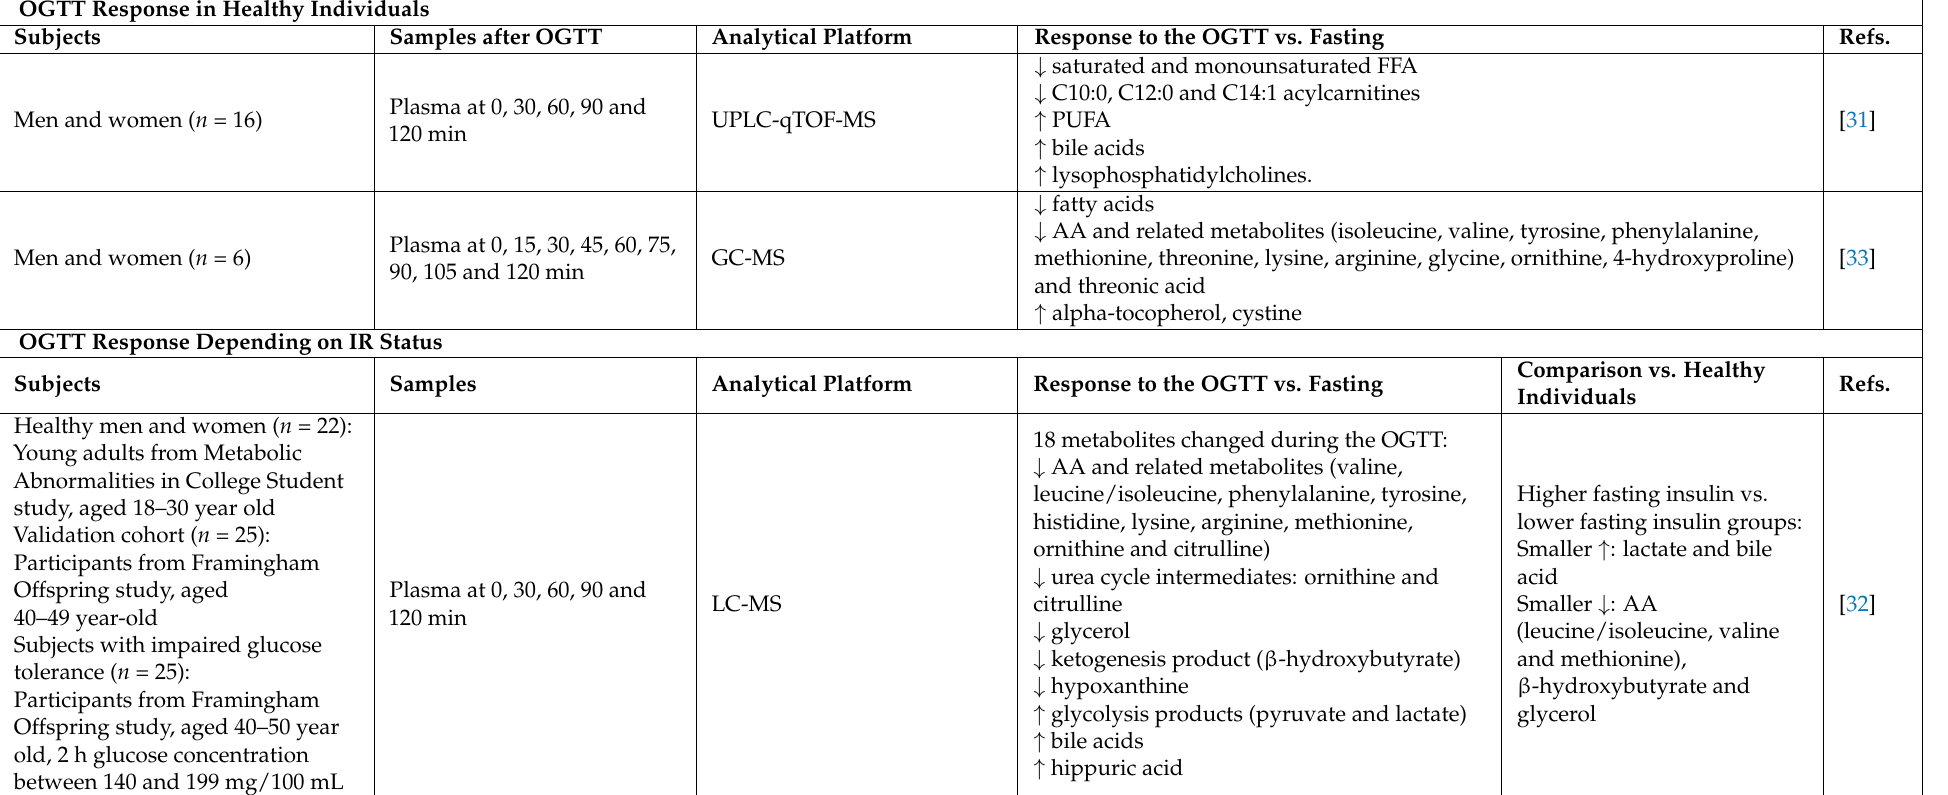
Table 1. Summary of reviewed studies investigating, with a metabolomics approach, the response to OGTT in